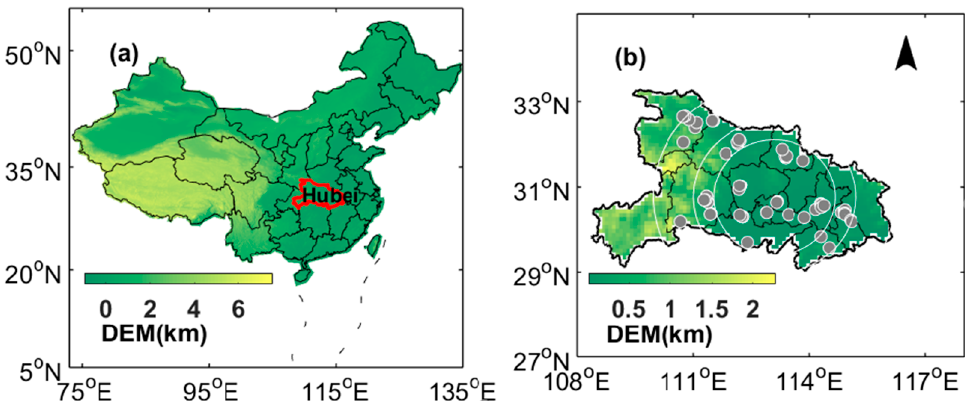
Figure 1. ( a ) Location of Hubei province (the region circled by the red line) in China. ( b ) Location of the monitoring sites (grey dots). The white arc represents the buffer (150, 150–200 and 200–300